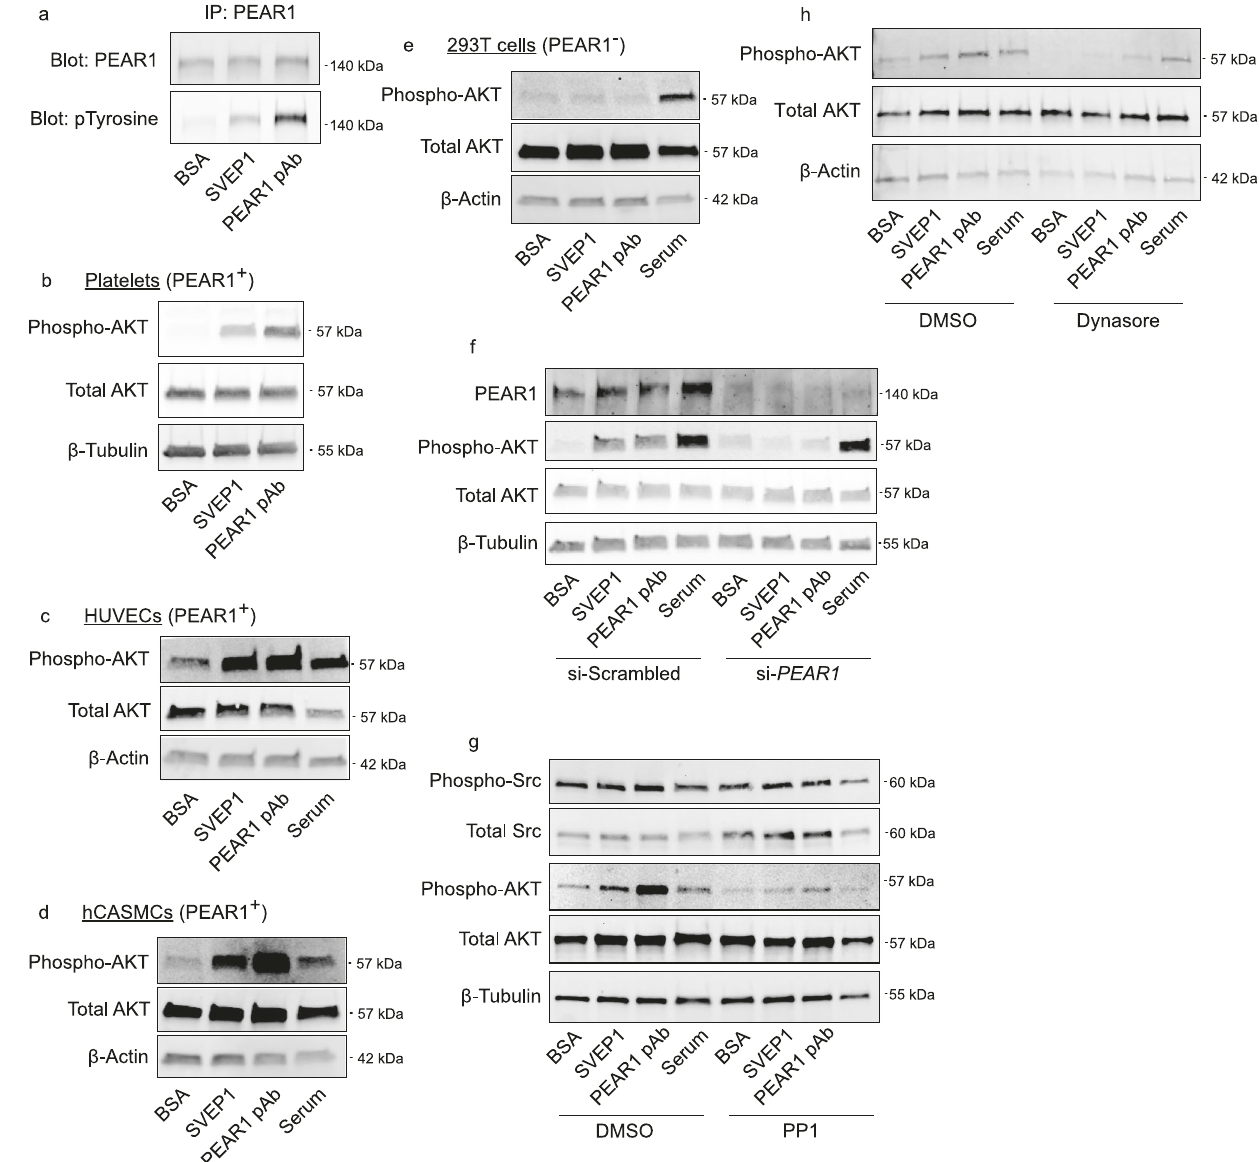
Fig.3|SVEP1activatesAKTsignalingthroughPEAR1.a Isolatedhumanplatelets were exposedto immobilized BSA,SVEP1, or soluble PEAR1 pAb for 15minprior to lysis. Lysates were subjected to immunoprecipitation with an anti-PEAR1 antibody